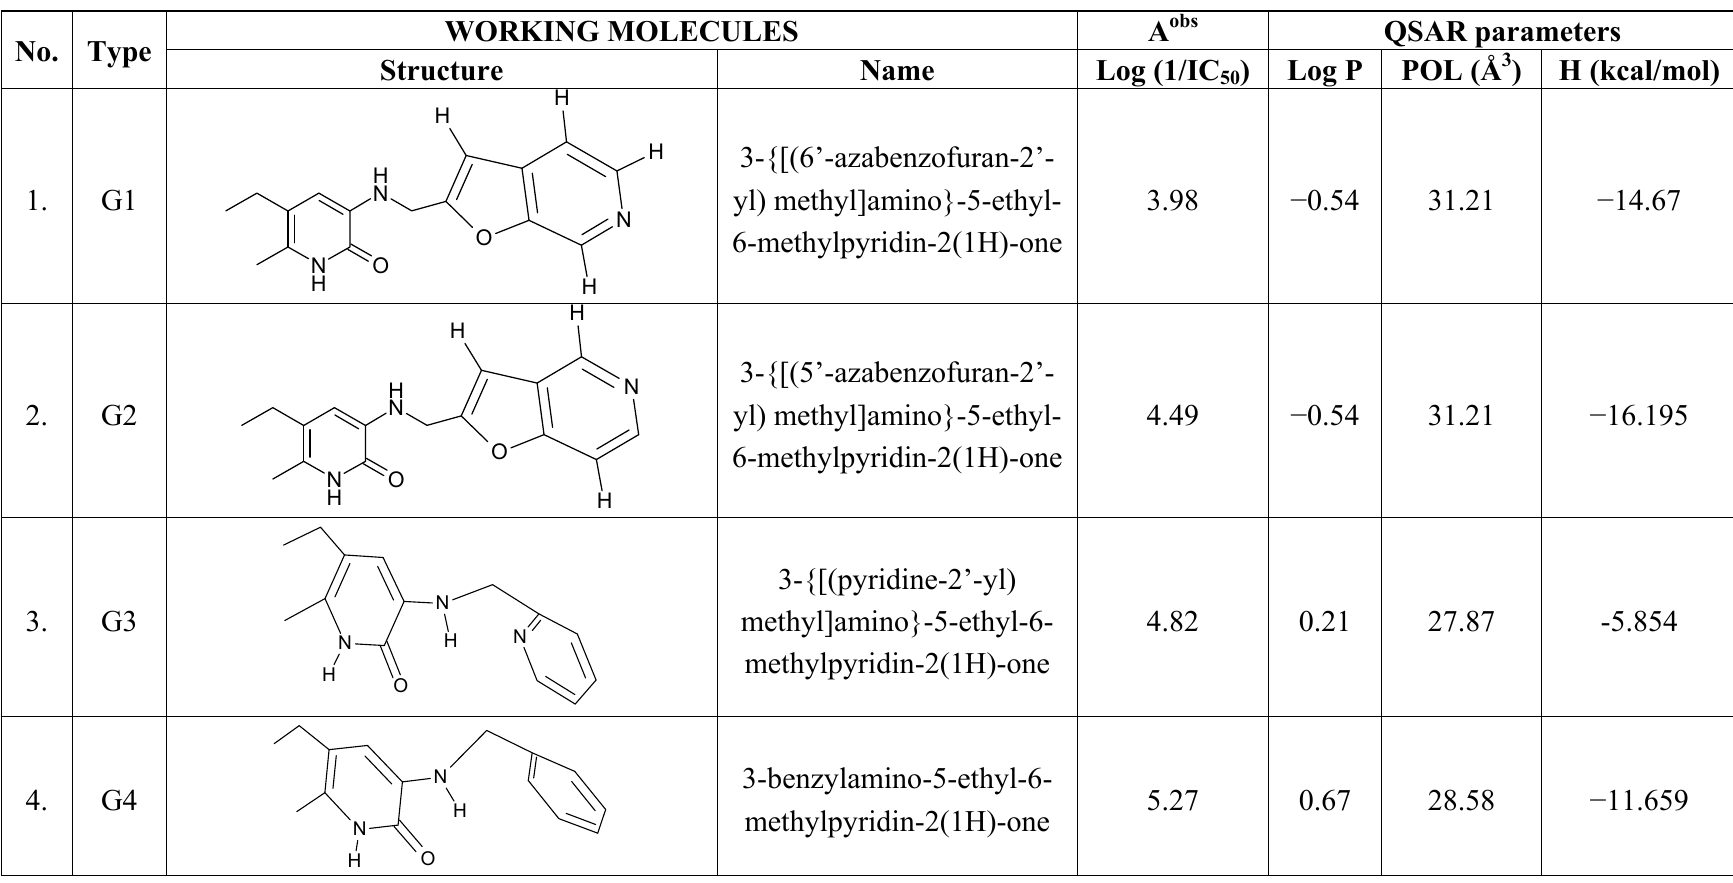
Table 4. Actual working reverse transcriptase pyridinone inhibitors grouped in Gaussian (G) and non-Gaussian (NG) molecular congeneric sets with their structural information (hydrophobicity, Log P; molecular polarizability POL [Å 3 ] and total optimized energy of formation H [kcal/mol]) computed upon the semi-empirical PM3 method [42], along with their observed activity A = Log (1/IC50)